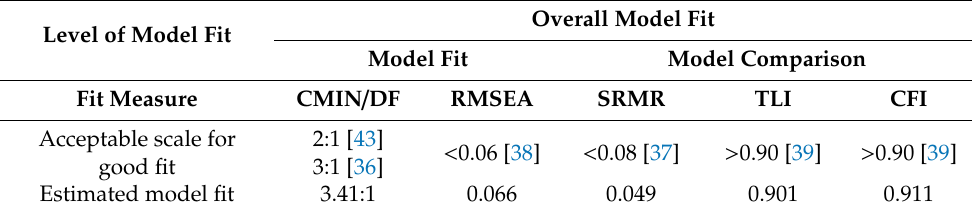
Table 7. Model fit indices.